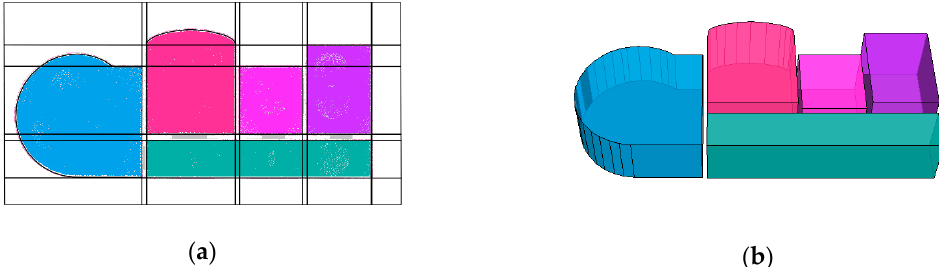
Figure 8. ( a ) Cell complex overlapping with the initial room segmentation raster and ( b ) constructed room